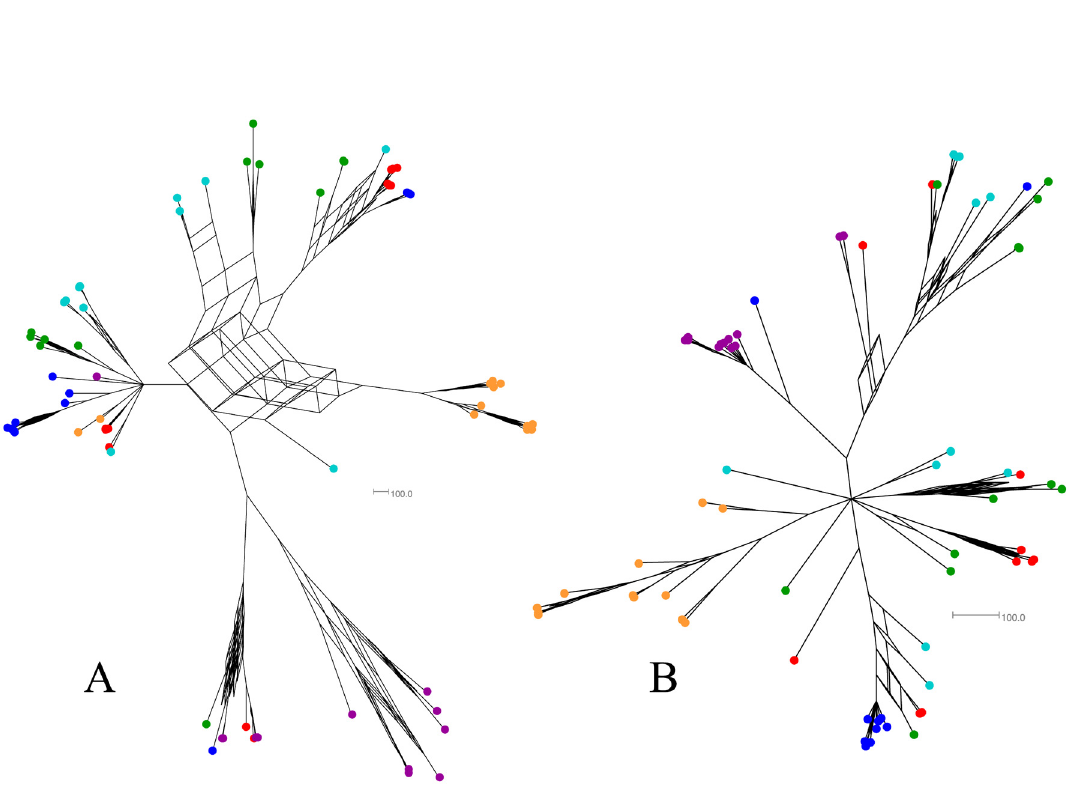
Fig 3. Example consensus network based on the E2 (A) and NS5B (B) gene fragment posterior tree sets for PI8. Tips are coloured according to their tissue of origin (tonsil = yellow, colon = green, MLN = blue, obex = purple, serum = orange, ileum = teal).